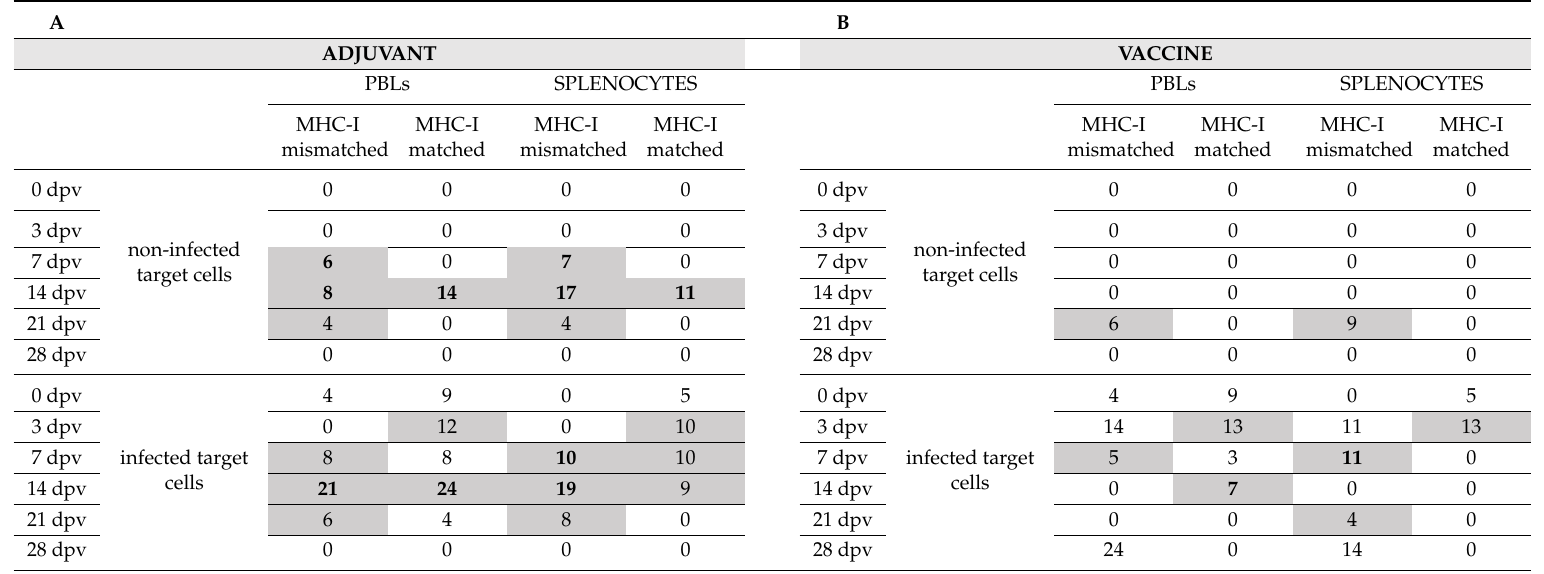
Table 3. Percentages of cytotoxicity in PBLs and splenocytes ( n = 3) at 0, 3, 7, 14, 21, and 28 days post injection with (A) adjuvant, (B) vaccine, (C) vaccinated and SAV, and (D) naïve and SAV challenge, against infected and non-infected MHC-I matched (RTG2) and mismatched (CHSE) cells. Grey shading signifies a percentage of cytotoxicity higher than observed with the control group (0 dpi) e ff ector cells; numbers in bold indicate percentage cytotoxicity is significantly ( p < 0.05) di ff erent compared to e ff ector cells from unstimulated